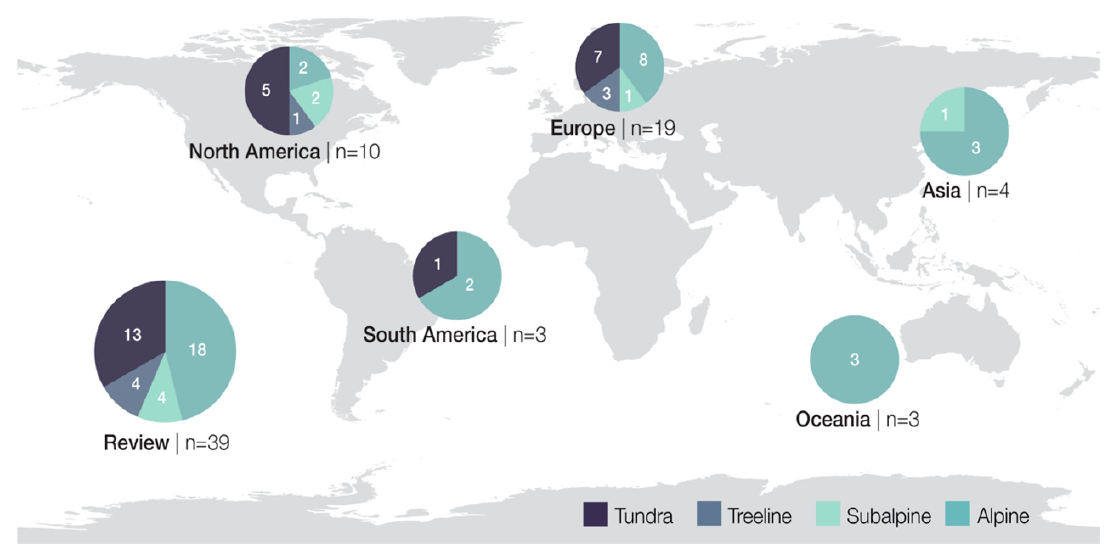
Figure 2. Geographic and ecosystem distribution of studies (within articles) that investigated the effects of climate change on early life-history stages of high altitude and high latitude plants.